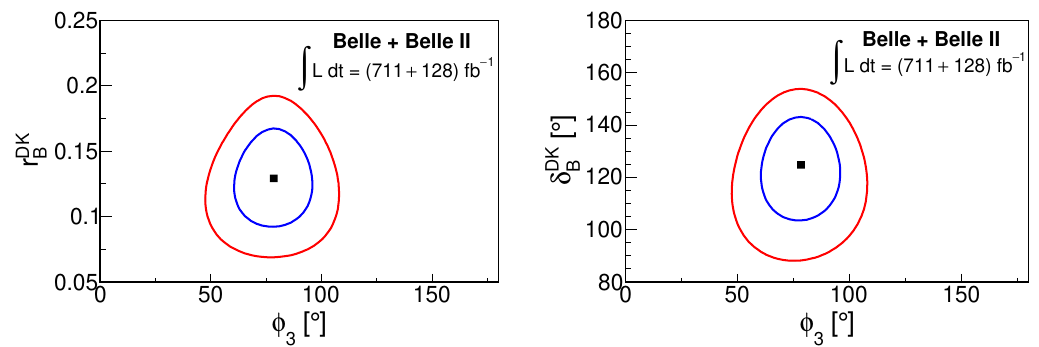
Figure 10 . p -value as a function of (left) φ 3 and (right) r DK in ref. [53].